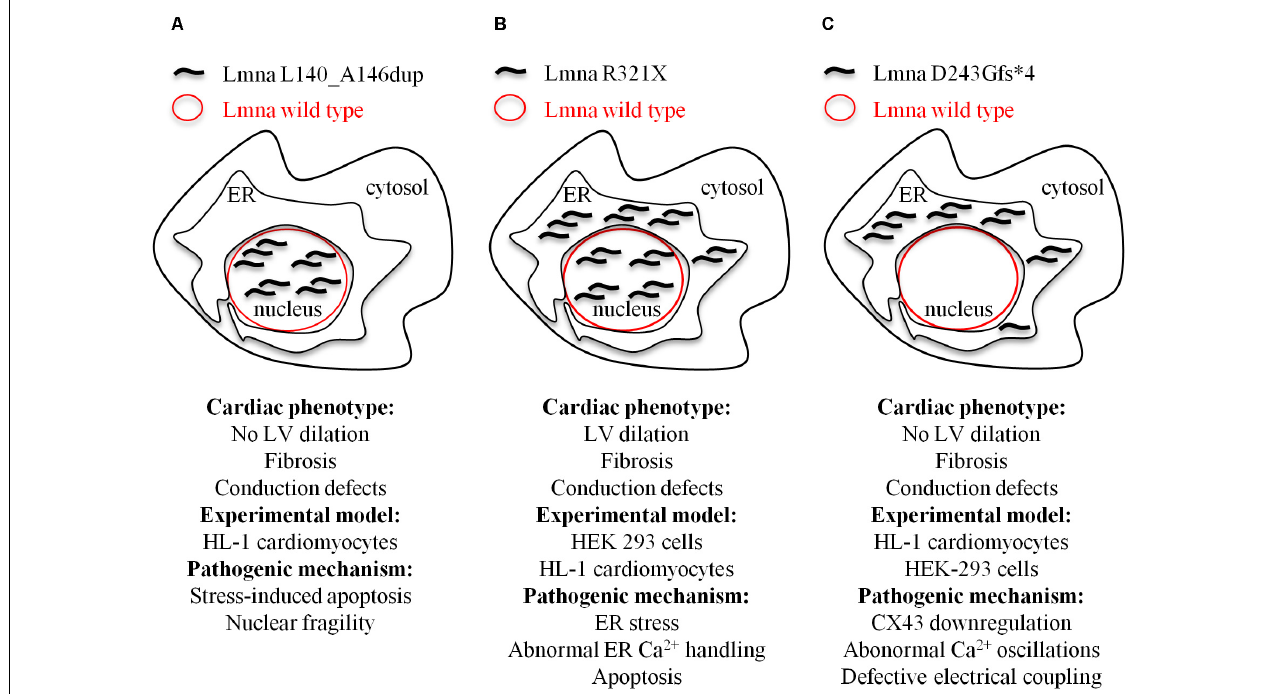
FIGURE 2 | Model depicting the cellular mislocalization of the three mutants of lamin A in light of the cardiac phenotypes of the probands and the experimental models used for the evaluation of the pathogenic mechanisms at cellular level. (A) Lmna L140_A146dup; (B) Lmna R321X; and (C) D243Gfs ∗ 4.